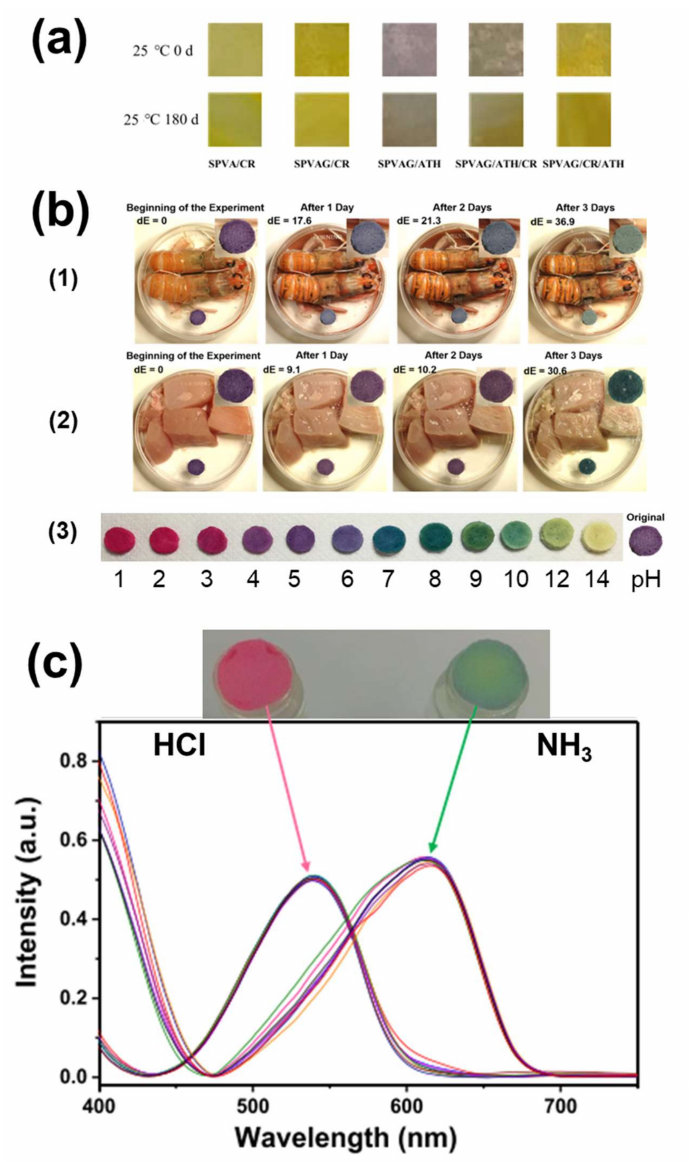
Figure 9. ( a ) Stability studies of PVA-starch based films with or without glycerol (SPVAG and SPVA, respectively) and with different combinations of curcumin (CR) and anthocyanins (ATH) (SPVA/CR, SPVAG/CR, SPVA/ATH, SPVAG/ATHCR, SPVAG/CR/ATH curcumin:anthocyanin ratio of 1:0, 1:0, 0:1, 2:8 and 8:2, respectively): images of the films the first and the 180th day of storage at 25 ◦ C. Adapted with permission from Ref. [80]. ( b ) Monitoring of spoilage of (1) prawns and (2) chicken using the red cabbage anthocyanin-loaded foams, (3) and their wide pH-induced color change. Adapted with permission from Ref. [31], ( c ) Optical images and UV–vis reflectance absorption spectra of anthocyanin dyed silk fabrics exposed to 8 cycles of HCl and NH 3 vapors. Adapted with permission from Ref.